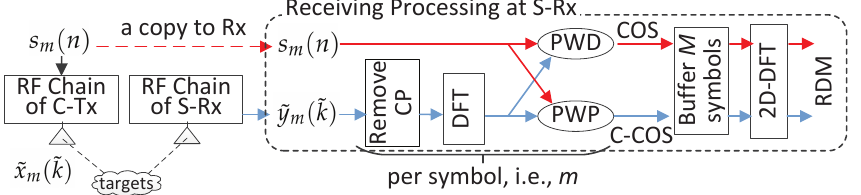
Figure 3. Illustrating the processing diagram of COS and C-COS, where C-Tx stands for communica- tion transmitter, S-Rx for sensing receiver, PWD for point-wise division, PWP for point-wise product and RDM for range–Doppler